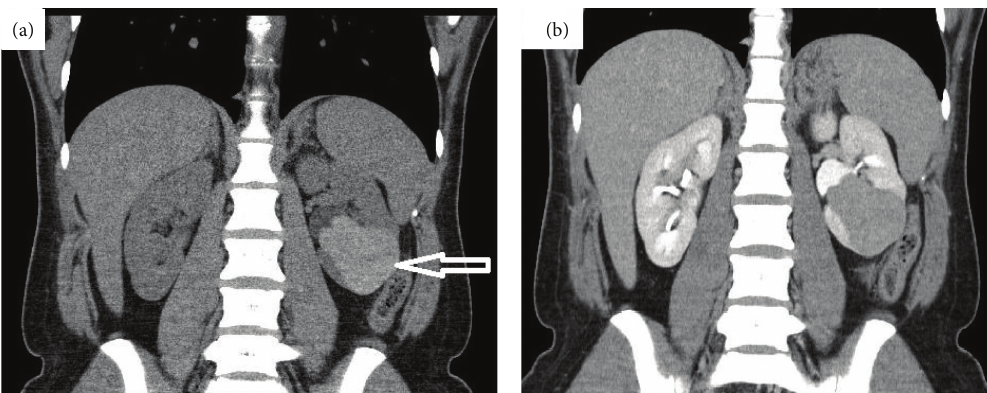
Figure 1: (a) Noncontrast coronal CT scan showing 5.7 × 4.9 × 5.8 cm mass in lower pole of left kidney (see arrow). (b) Postcontrast coronal CT scan showing no measurable enhancement.